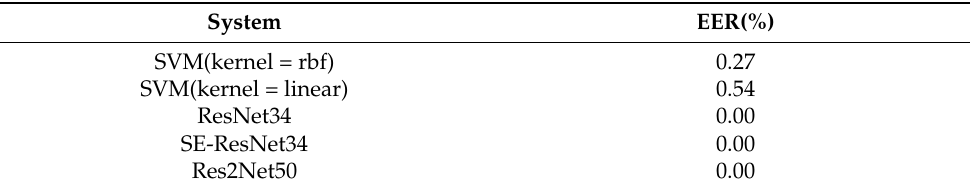
Table 5. The performance at high sampling